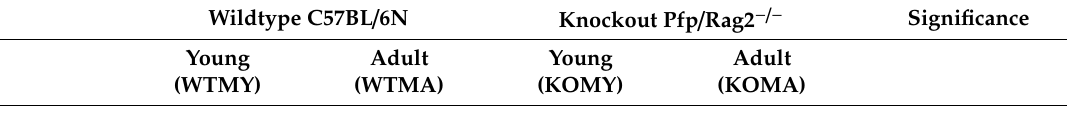
Table 3. Serum adipokines and